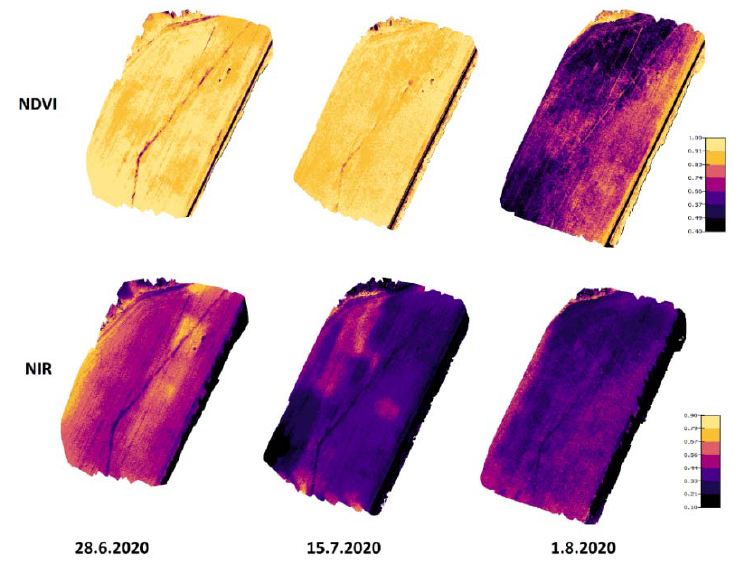
Figure 8. NIR and NDVI development on Koirasuo field during the growing season in 2020. The Zadoks values were 69 (28.6), 83 (15.7), and 86 (1.8). The orthomosaic maps were created from pictures taken at 12:00.